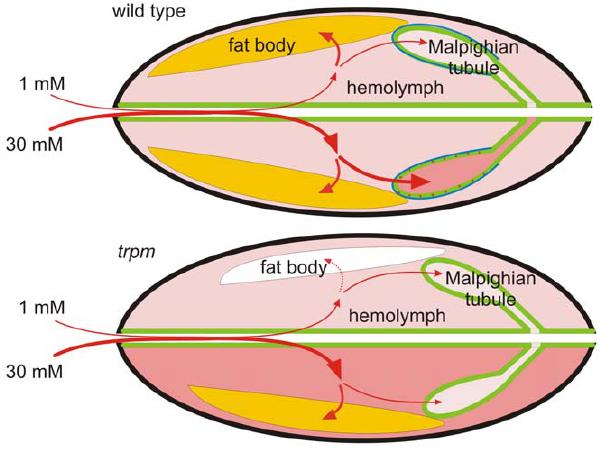
Figure 6. Schematic showing the changes in Mg 2 + homeostasis in trpm mutant larvae. The upper and lower halves of the wild-type and trpm larvae depict the main net transport paths for Mg 2 + upon feeding on a diet containing 1 mM or 30 mM Mg 2 + . The thicker red lines and the darker hue of the background redness over the hemolymph space and the Malpighian tubules represent the higher Mg 2 + concentration/density in their respective compartments. The white fat body indicates low synthetic capacity. The blue outlines on the initial and transitional segments of the wild-type Malpighian tubules delineate the localization of the TRPM protein.